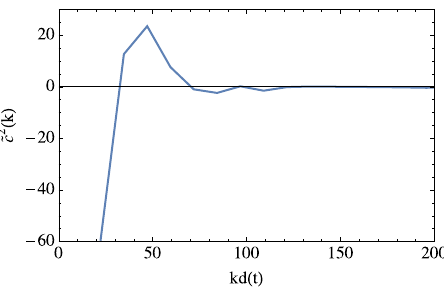
Fig. 7 The direct correlation function for triple junctions. The Fourier transform of the direct correlation function, ~ c ð 2 Þ k ð Þ , versus kd ( t ) for the Al microstructures annealed for 150 minutes at T = 400 °C.